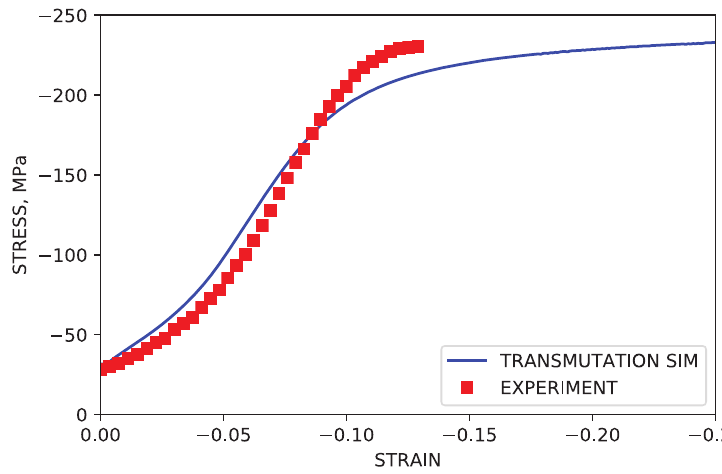
Figure 12. Simulated IPC stress curve with transmutation active in the basal mode